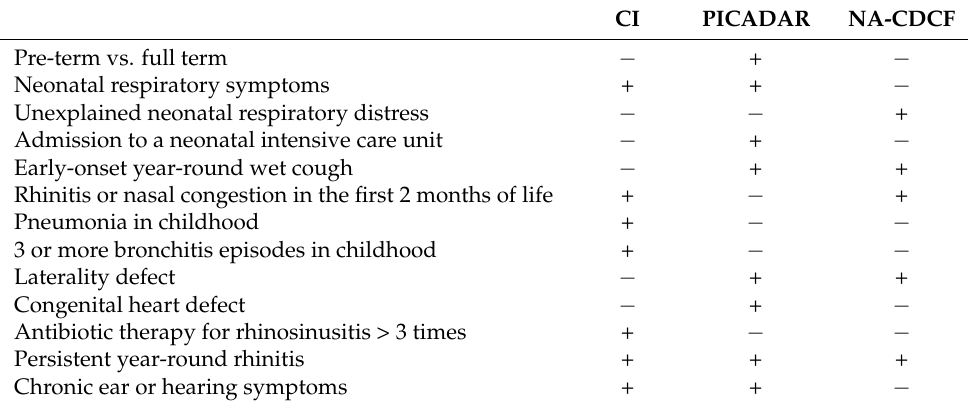
Table 2. Overview of signs and symptoms present in the CI, PICADAR, and NA-CDCF